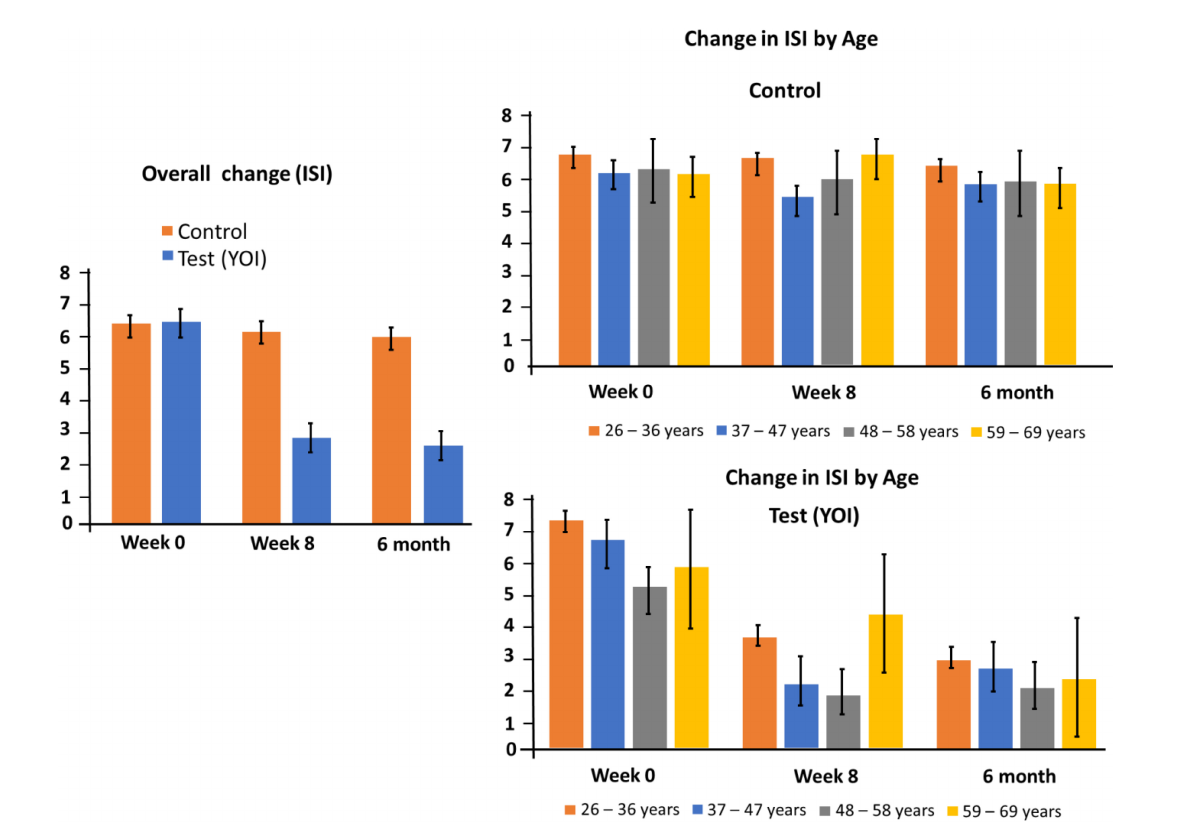
FIGURE3 Changes in ISI at week 0, 8 and 20. Left panel: overall change for controls and participants. Right panel: subgroup changes by